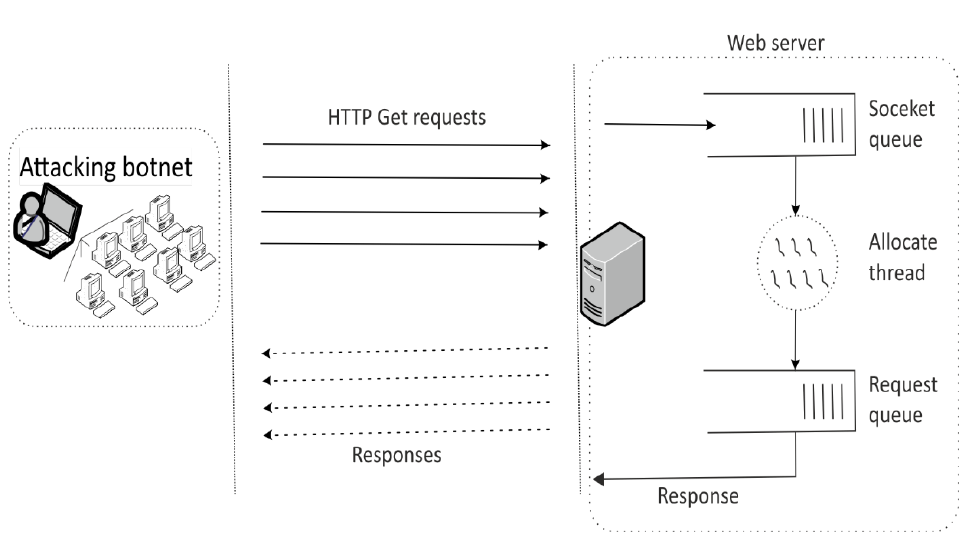
Figure 3. HTTP Get flood DDoS attack.